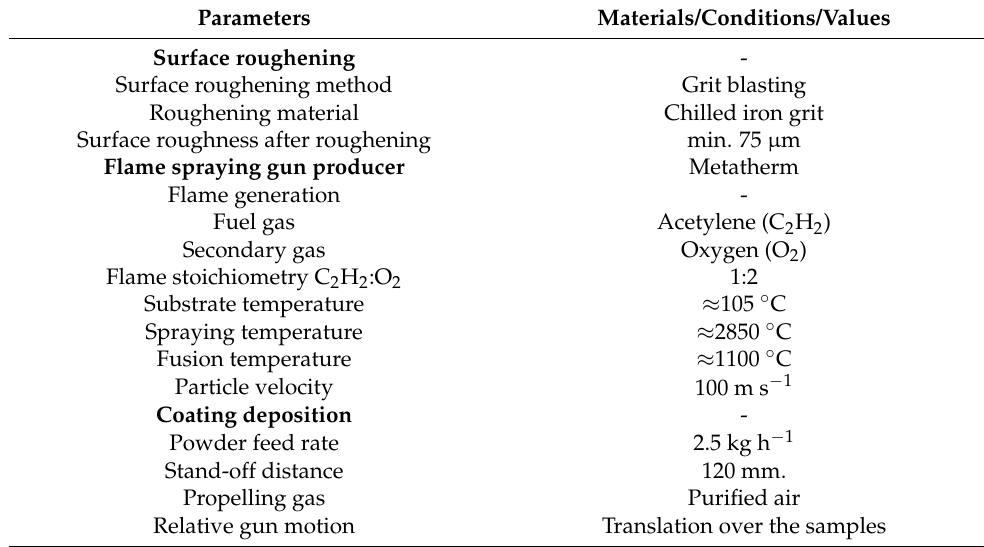
Table 2. Deposition parameters.